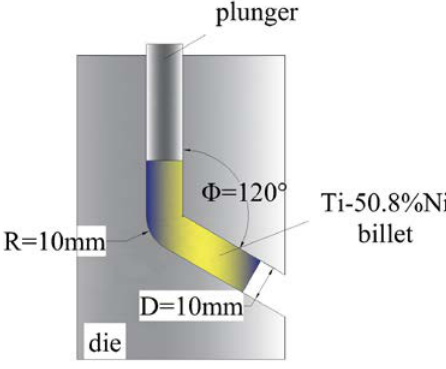
Figure 1. FEM model for ECAP process.